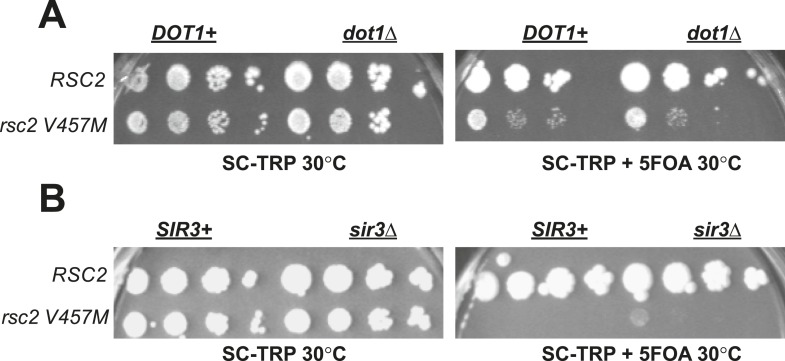
Rsc2 mutations are not suppressed by dot1Δ or sir3Δ.(A) dot1Δ does not suppress rsc2-V457M. YBC803 (rsc1Δrsc2Δ [RSC1.URA3]) and YBC1683 (rsc1Δ rsc2Δ dot1Δ [RSC1.URA3]) were transformed with TRP1-marked RSC2 (p604) or rsc2-V457M (p776) and spotted to SC-TRP 30°C and SC-TRP + 5FOA 30°C. (B) A null mutation in SIR3 does not suppress rsc2-V457M. YBC803 (rsc1Δrsc2Δ [RSC1.URA3]) and YBC3185 (rsc1Δ rsc2Δ sir3Δ [RSC1.URA3]) were transformed with TRP1-marked RSC2 (p604) or rsc2-V457M (p776) and spotted to SC-TRP 30°C and SC-TRP + 5FOA 32°C.